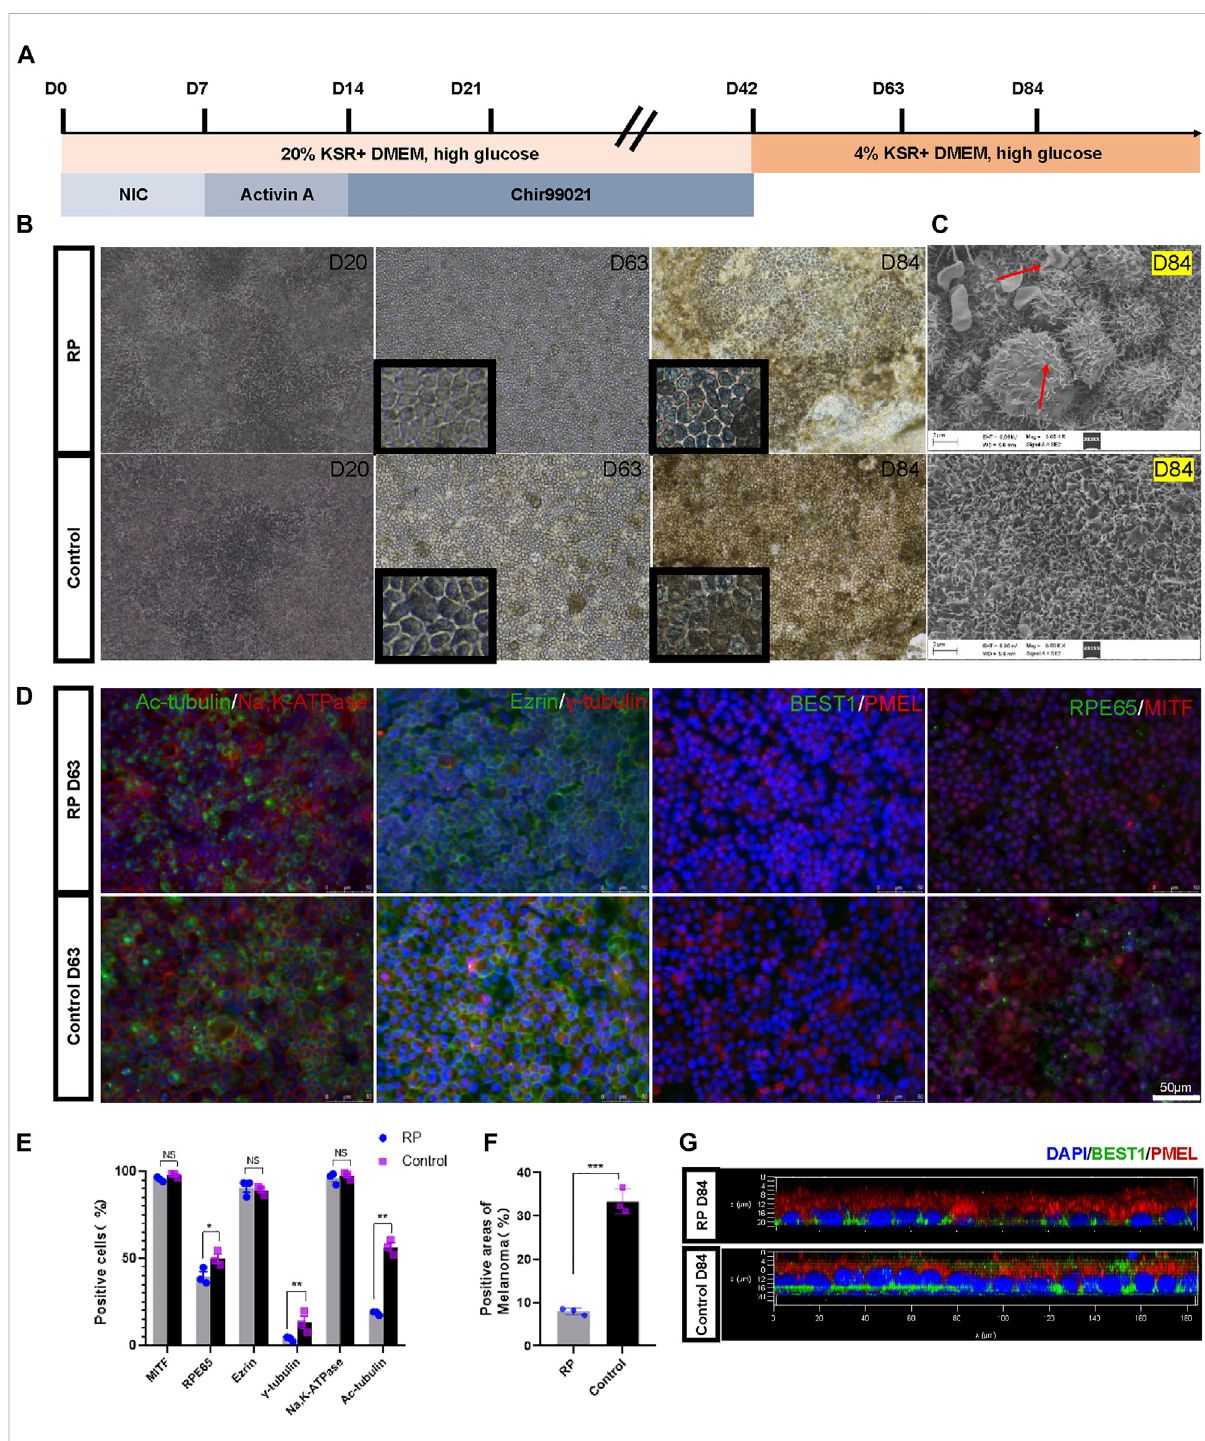
FIGURE 2 Directed differentiation protocol of RPE cells. (A) Schematic representation of the protocol. (B) Representative images of RPE cells at days 20, 63 and 84. (C) SEM images of RPE cells at D84. (D) Immuno fl uorescent staining of RPE speci fi c markers. (Scale bar, 50 μ m) (E – F) Positive cells or areasanalysis. (G) Confocal micrographs ofRPEcellsstainedwith BEST1(green) andPMEL (red).Dataare shownas mean±SD.* p < 0.05, ** p < 0.01, *** p < 0.001, ns: no signi fi cance ( n =